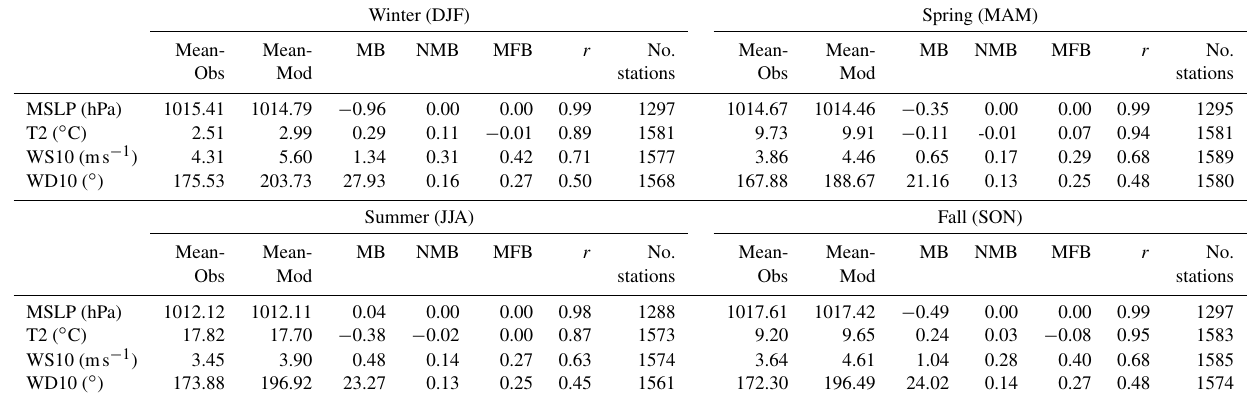
Table 4. Domain-wide statistical performance of WRF-Chem against 3-hourly meteorological observations from BADC. Modeled quantities are from the MOZART